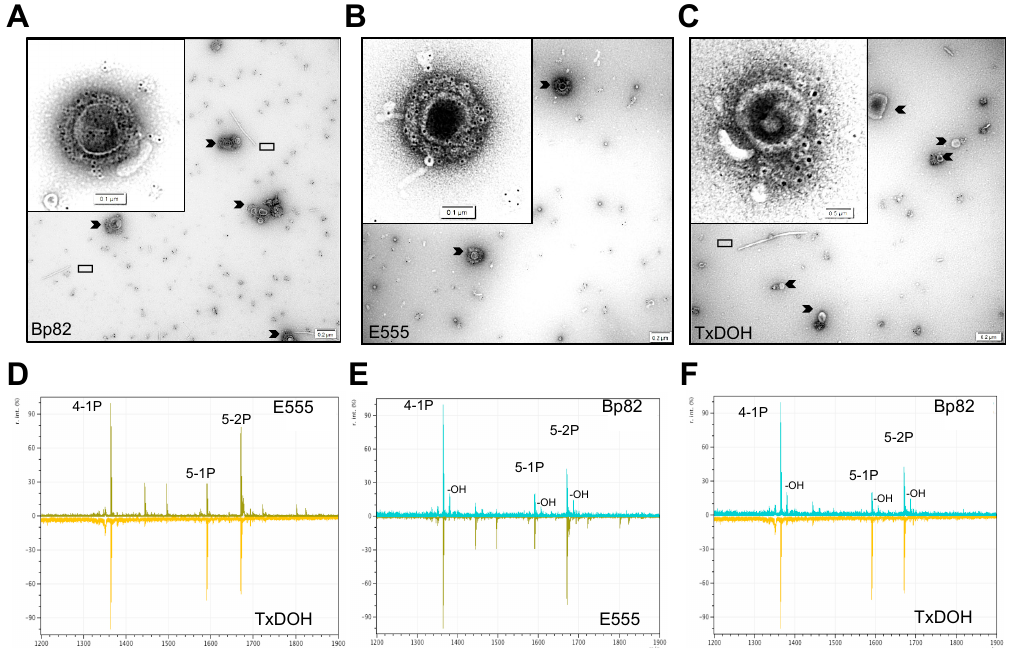
Figure 2. Transmission electron microscopy of capsular polysaccharides and lipid A moieties present in OMV production strains. ( A – C ) TEM images of Bp82, E555, and TxDOH-derived OMVs (chevrons), insets are zoomed images of CPS (mAb 4C4 specific immunogold labeling; black dots) in close association with the OMVs. ( D – F ), MALDI-TOF/TOF mass scans of lipid A purified from the indicated strains. Flagellar fragments are indicated by caret symbols. ( D ) E555 (top, olive) compared to TxDOH (bottom, gold) lipid A. ( E ) Bp82 (top, cyan) compared to E555 (bottom, olive) lipid A. ( F ) Bp82 (top, cyan) compared to TxDOH (bottom, gold) lipid A. 4-1P, mass peak of tetra-acylated singly phosphorylated lipid A; 5-1P, mass peak of penta-acylated singly phosphorylated lipid A; 5-2P, mass peak of penta-acylated doubly phosphorylated lipid A; -OH, indicates additional hydroxyl groups not present in B. thailandensis lipid A moieties.